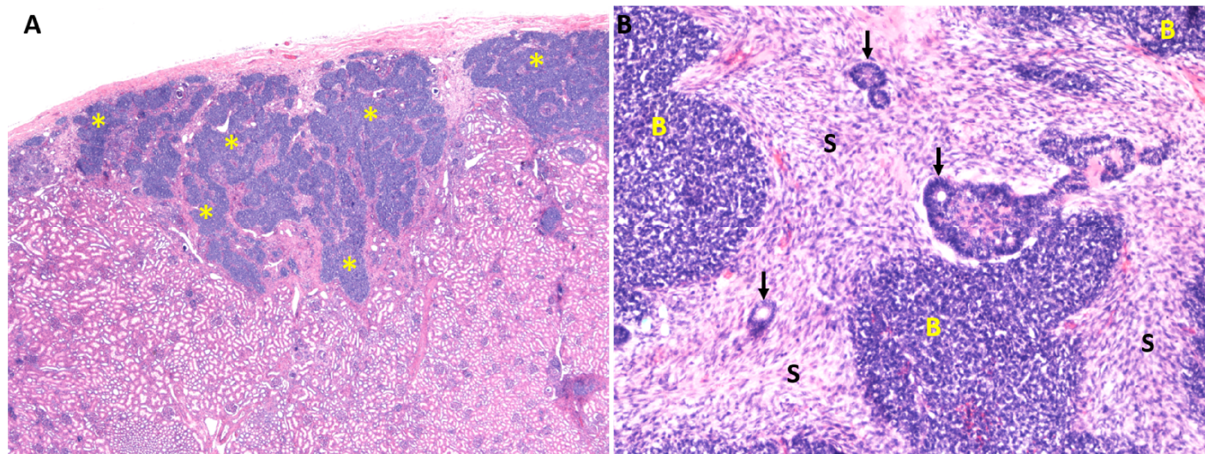
Figure 1. Nephroblastomatosis and Wilms tumor. ( A ) An example of human postnatal kidney with nephrogenic rests (asterisks) of the nephroblastomatosis, which are seen as tightly packed darker blue cells in the renal cortex. ( B ) An example of human kidney with the classical morphology of Wilms tumor. It resembles embryonic kidney by exhibiting blastemal ( B ), stromal (S), and epithelial cells (arrows), which, however, fail to organize into typical tissue structures.